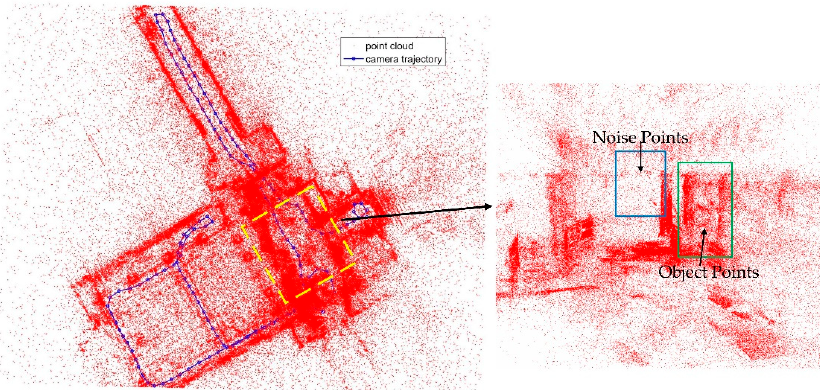
Figure 14. Noise points in the feature 3D points.